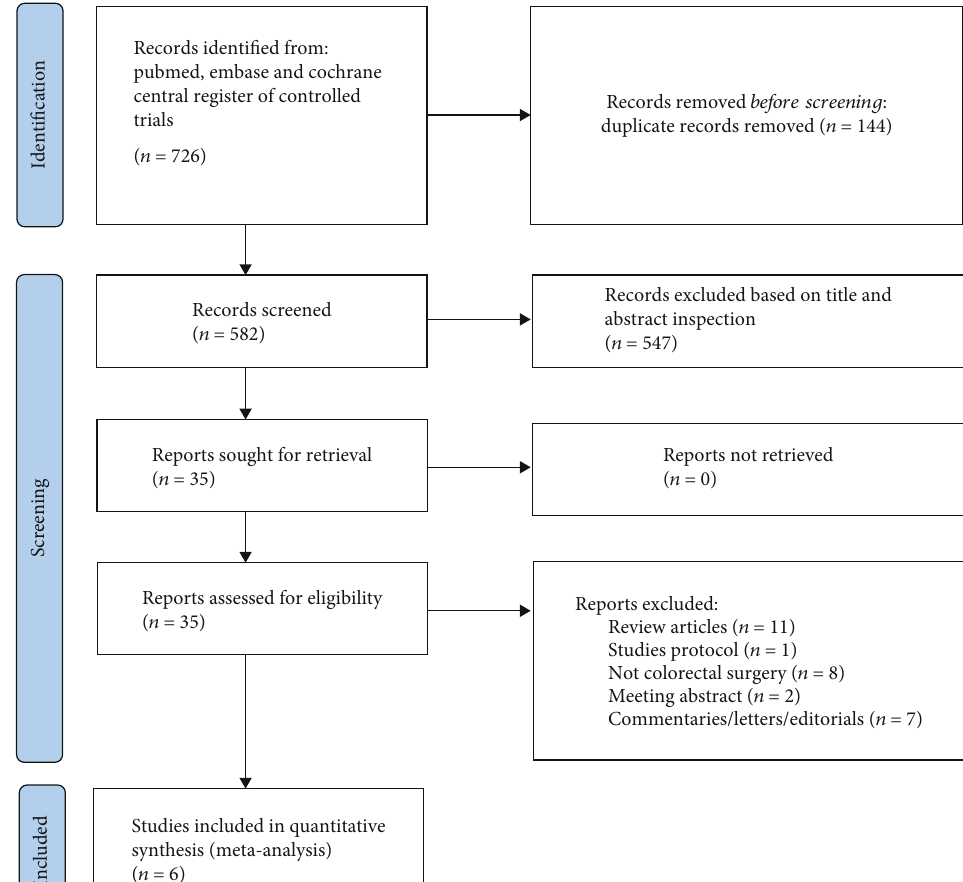
Figure 1: PRISMA fl ow diagram of the study search